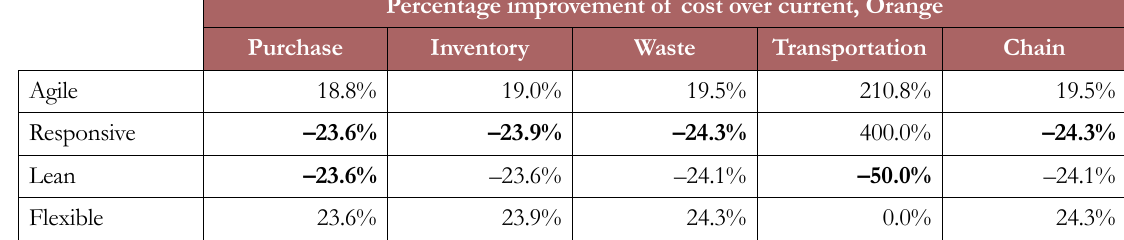
Table 9b. Pe.rcentage Change cost for Orange